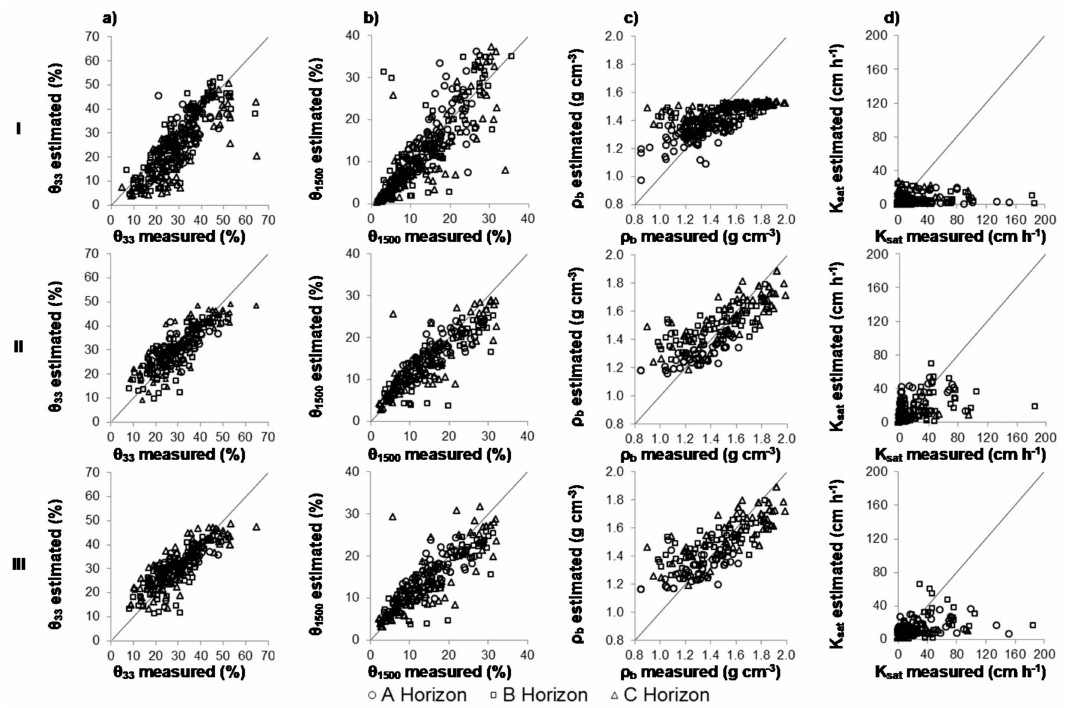
Figure 4. Accuracy assessment of Saxton and Rawls’s PTFs ( I ) and PTFs developed using SFR ( II ) and CCA ( III ): ( a ) field capacity ( θ 33 ); ( b ) permanent wilting point ( θ 1500 ); ( c ) bulk density ( ρ b ); ( d ) saturated hydraulic conductivity (K sat